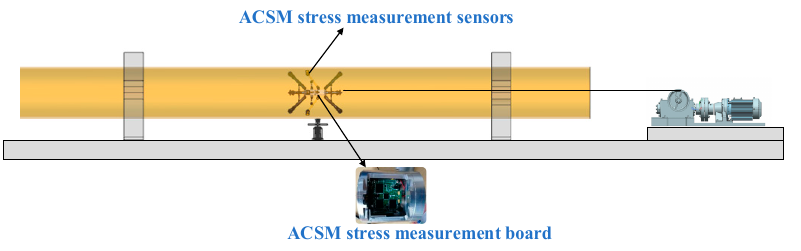
Figure 23. Assembly diagram of the stress measuring instrument.